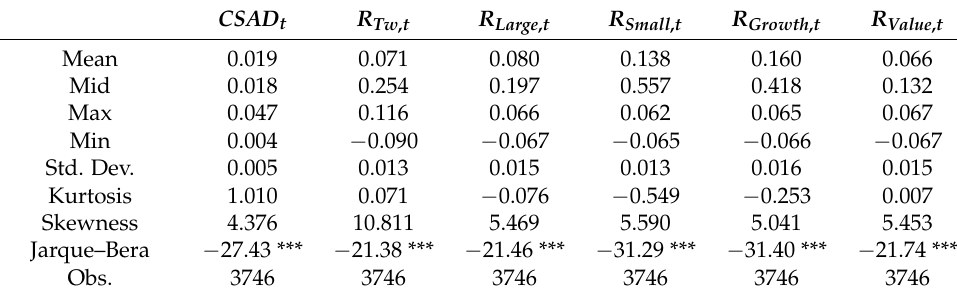
Table 1. A summary of statistics and results of unit root tests. CSAD t R Tw , t R Large , t R Small , t